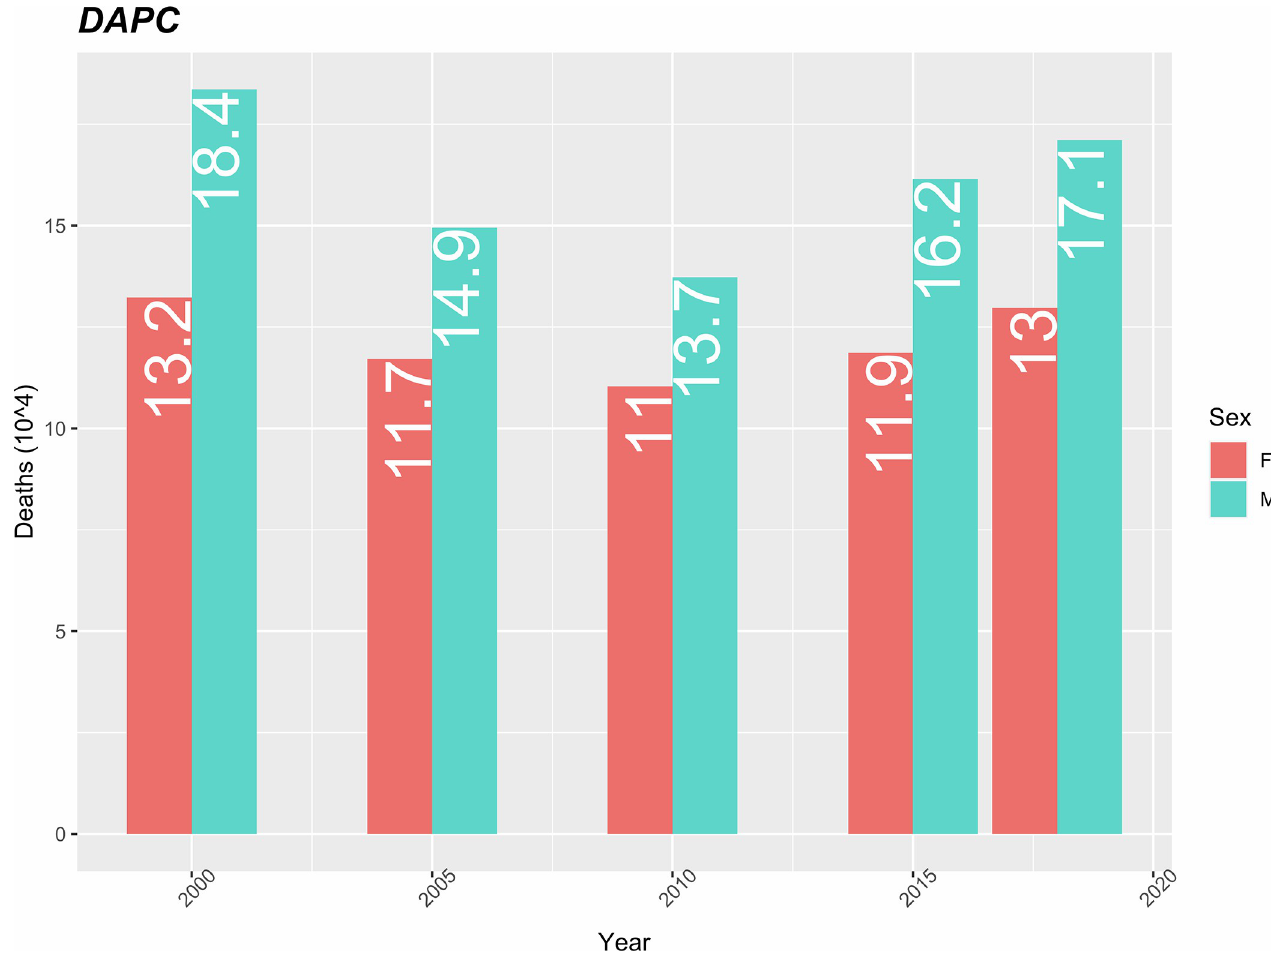
Fig 5. Mortality rate due to DAPC (10 thousand) standardized by